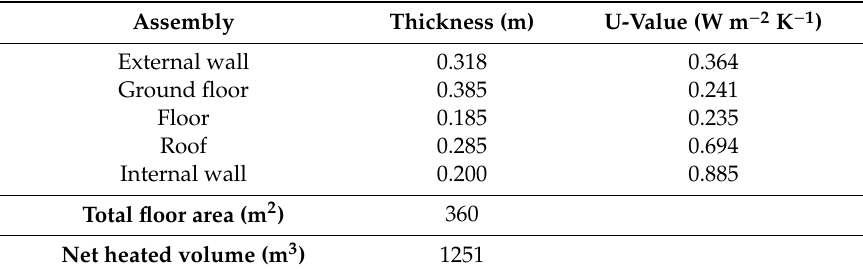
Figure 2. Tri-dimensional view of the residential building considered in the present paper. Table 1. Geometrical and thermo-physical data of the building envelope components.